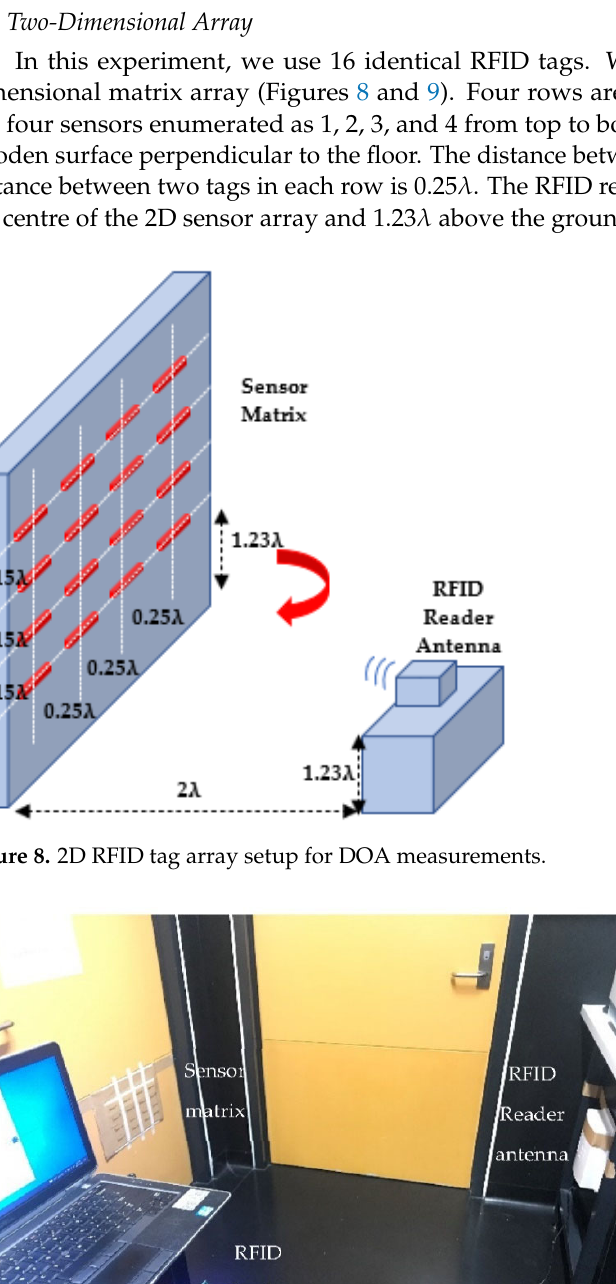
Figure 10. Utilised 2D sensor array. V1,…, V4 are the DOA of the columns and H1,…, H4 are the DOA of the rows estimated by the MUSIC algorithm. For a greater number of sensor arrays, to increase the DOA performance, cascade algorithms such as MUSIC have already been used in the literature [52]. To this end, we calculated the MUSIC angle separately for each vertical and horizontal position at 0°, 10°, and 20° azimuth angles at 921 MHz operating frequency. Then, we used the estimated vertical DOA values (V1, V2, V3 and V4) in the MUSIC algorithm as a cascade again. The first MUSIC angle estimation was based on the inter ‐ sensor distance of 0.15 λ . Similarly, we used the estimated horizontal DOA values (H1, H2, H3 and H4) in the MUSIC algo ‐ rithm again. The second MUSIC angle estimation was based on the inter ‐ sensor distance of 0.25 λ . The largest errors were 11° and 15° for the vertical and horizontal directions. For the second test, we rotated the RFID reader antenna by 90°. The DOA estimation error is affected by the RFID reader antenna polarisation, sensor number and spacing, multipath propagation, and reading noise/error. Although increasing the number of sensors and using the cascade MUSIC algorithm in matrix sensor tests increases the DOA estimation accuracy, it also causes data loss due to increased distance. For this reason, RFID reader output power, antenna gain, and radi ‐ ation pattern should be considered to minimise data loss. A 2D sensor array can help determine twisting and stretching caused by asymmetric stress on the structure. For instance, an RFID reader antenna can be placed at the rigidity centre in a tall building. Moreover, a 2D sensor array installed on a shear wall can help monitor the stiffness of the shear wall when it is exposed to any external stress, such as lateral load due to an earthquake.